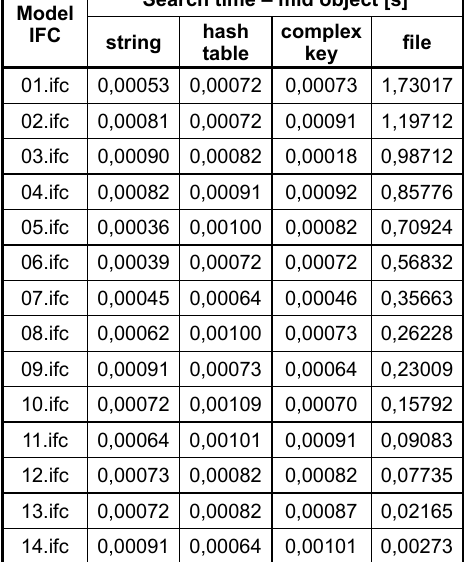
Tab. 10. List of middle objects reading times in test models from the database in each of the three pro- posed data models and from a text file